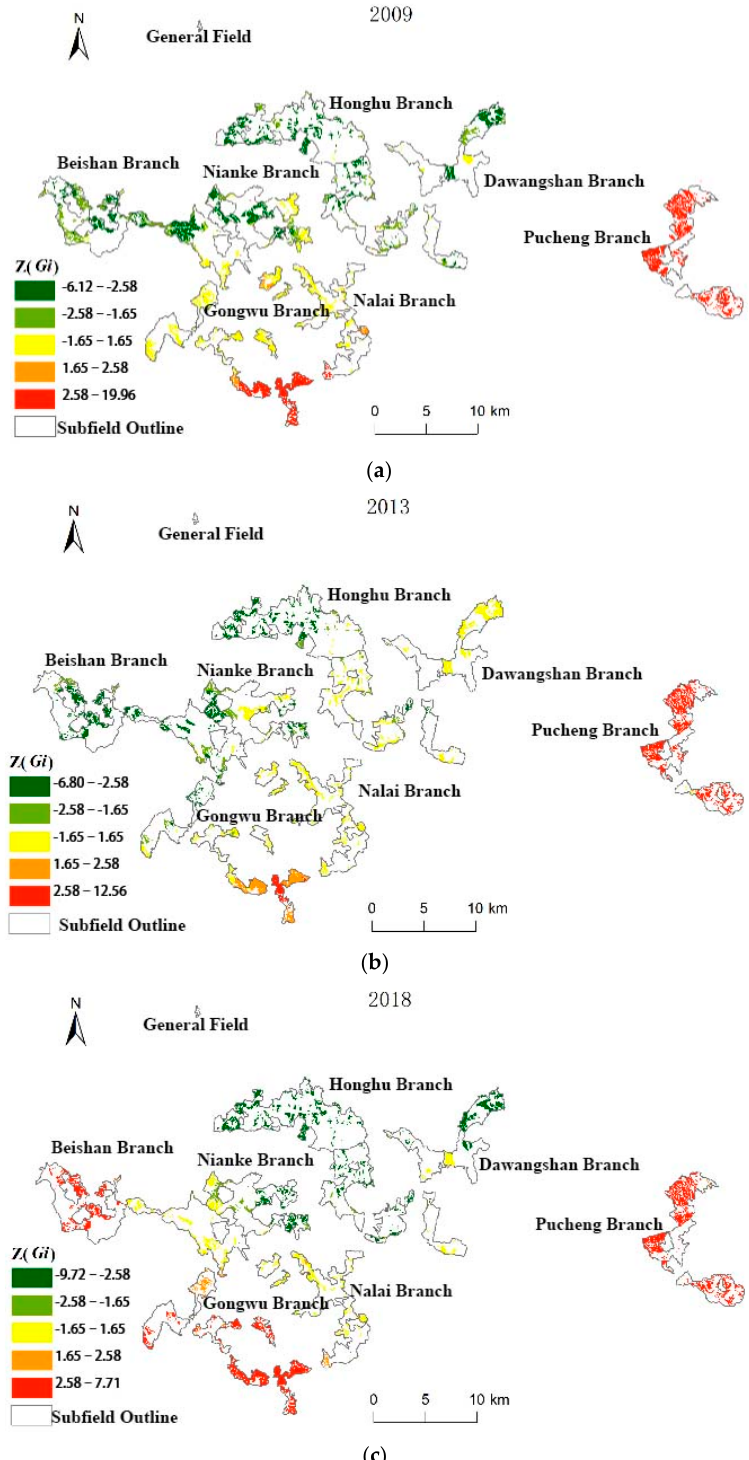
Figure 9. Distribution of cold–hot spots of water conservation in PM Plantations at Paiyangshan Forest Farm, 2009–2018. The aggregation index degree parameter Z(Gi*) was used to analyze the spatial pattern of water conservation services. Red indicates hot spot regions, orange indicates sub-hot spot regions, yellow indicates insignificant regions, dark green indicates cold spot regions, and light green indicates sub-cold spot regions. The following maps show the distribution of cold–hot spots of water conservation services in 2009 ( a ), 2013 ( b ), and 2018 ( c ), respectively.